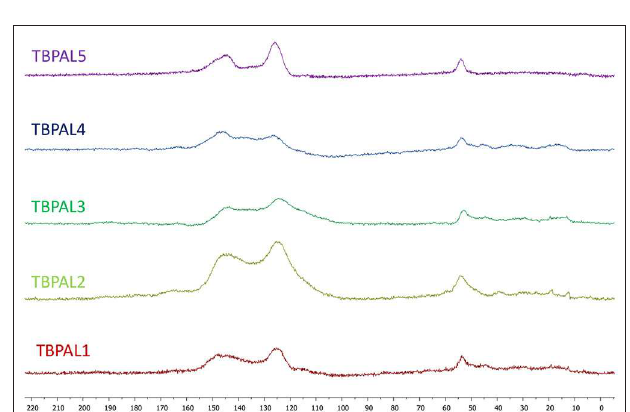
FIGURE 1 | 13 C CP-MAS NMR spectrum of TBPAL1–5 .